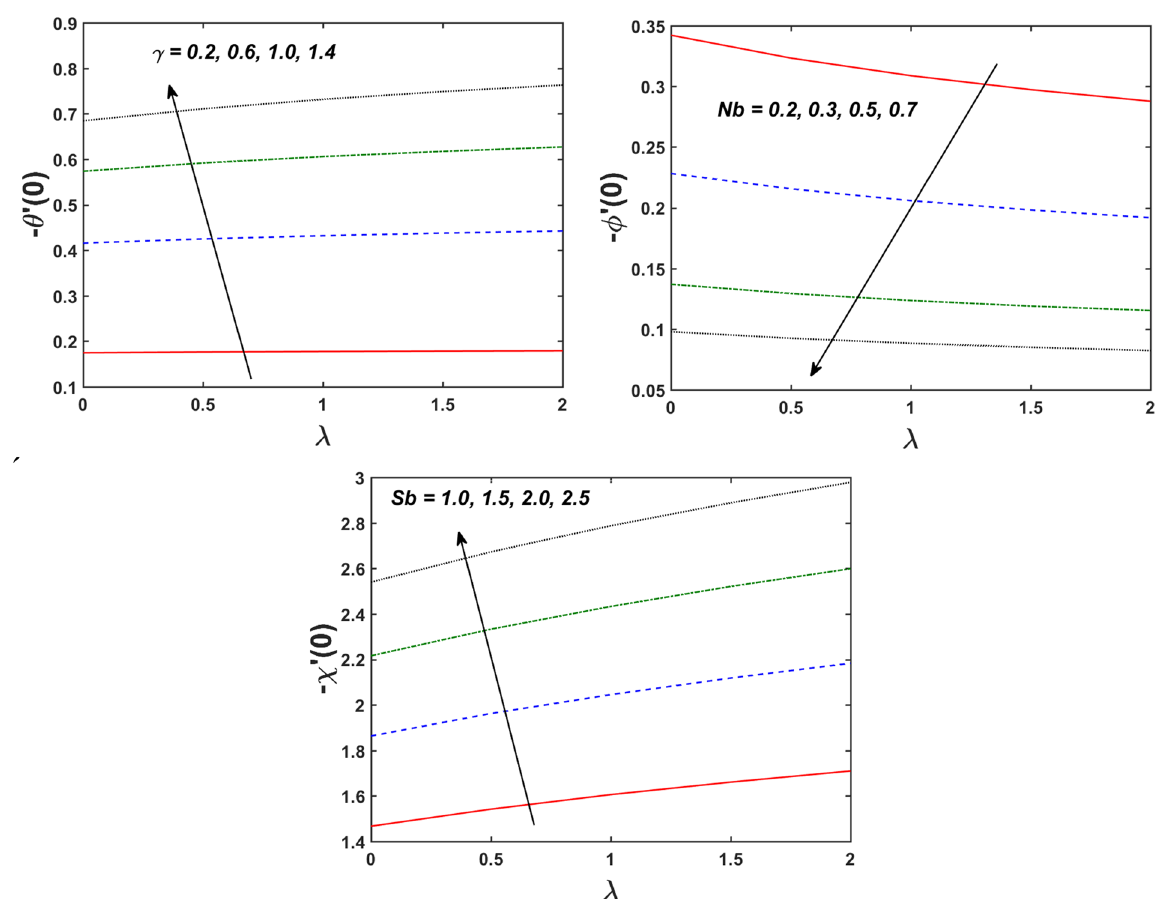
Figure 12. Variation of Nusselt number, Sherwood number and microorganism number for distinct